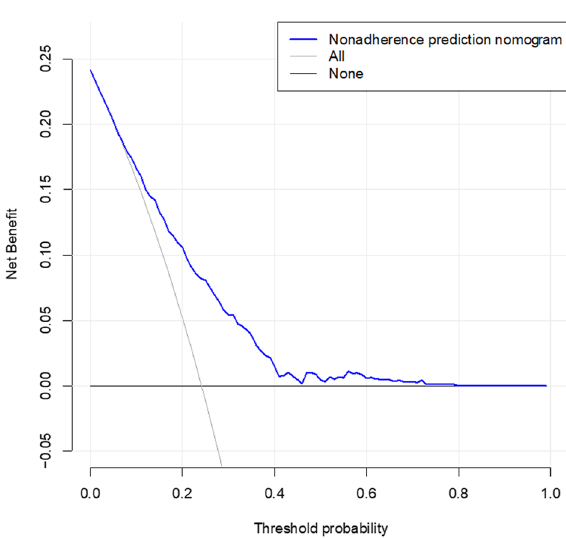
Figure 4. Decision curve analysis of TV